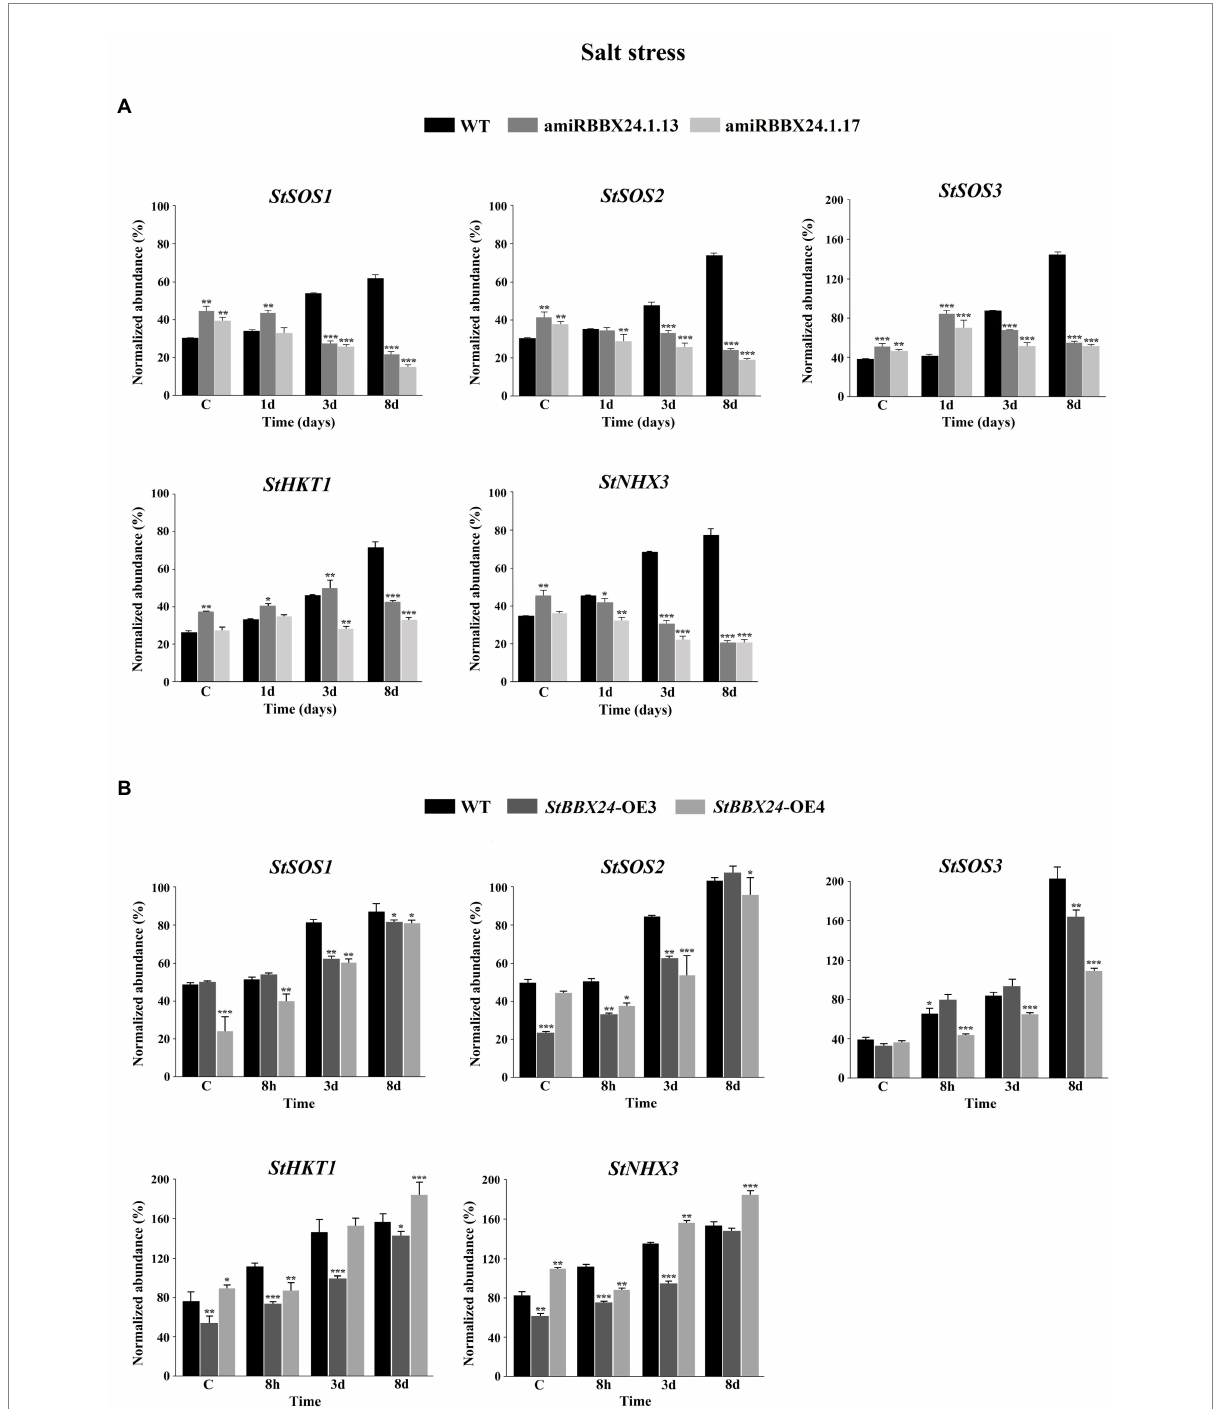
FIGURE 7 Changes in the expression of StSOS1 , StSOS2 , StSOS3 , StHKT1 and StNHX3 genes in control conditions and plants subjected to high salt for 8 h, 3 and 8 days. (A) Quantitative RT-PCR analysis of StSOS1 (ID: PGSC0003DMG400010630), StSOS2 (ID: PGSC0003DMG400006384), StSOS3 (ID: PGSC0003DMG400019601), StHKT1 (ID: PGSC0003DMT400077052) and StNHX3 (ID: PGSC0003DMG400034953) transcript abundance in leaves of 3-week-old phytotron-grown WT, amiRBBX24.1.13 and amiRBBX24.1.17 plants. (B) Quantitative RT-PCR analysis of StSOS1 (ID: PGSC0003DMG400010630), StSOS2 (ID: PGSC0003DMG400006384), StSOS3 (ID: PGSC0003DMG400019601), StHKT1 (ID: PGSC0003DMT400077052) and StNHX3 (ID: PGSC0003DMG400034953) transcript abundance in leaves of 3-week-old phytotron-grown WT, StBBX24 -OE3 and StBBX24 -OE4 lines. Quantitative RT-PCR was performed as described in Materials and methods. Means ± SD of four values from two independent experiments (two replicates per experiment) are presented. *, ** and ***, values significantly different from the WT value ( t -test) with p < 0.05, p < 0.01 and p < 0.001, respectively. WT,